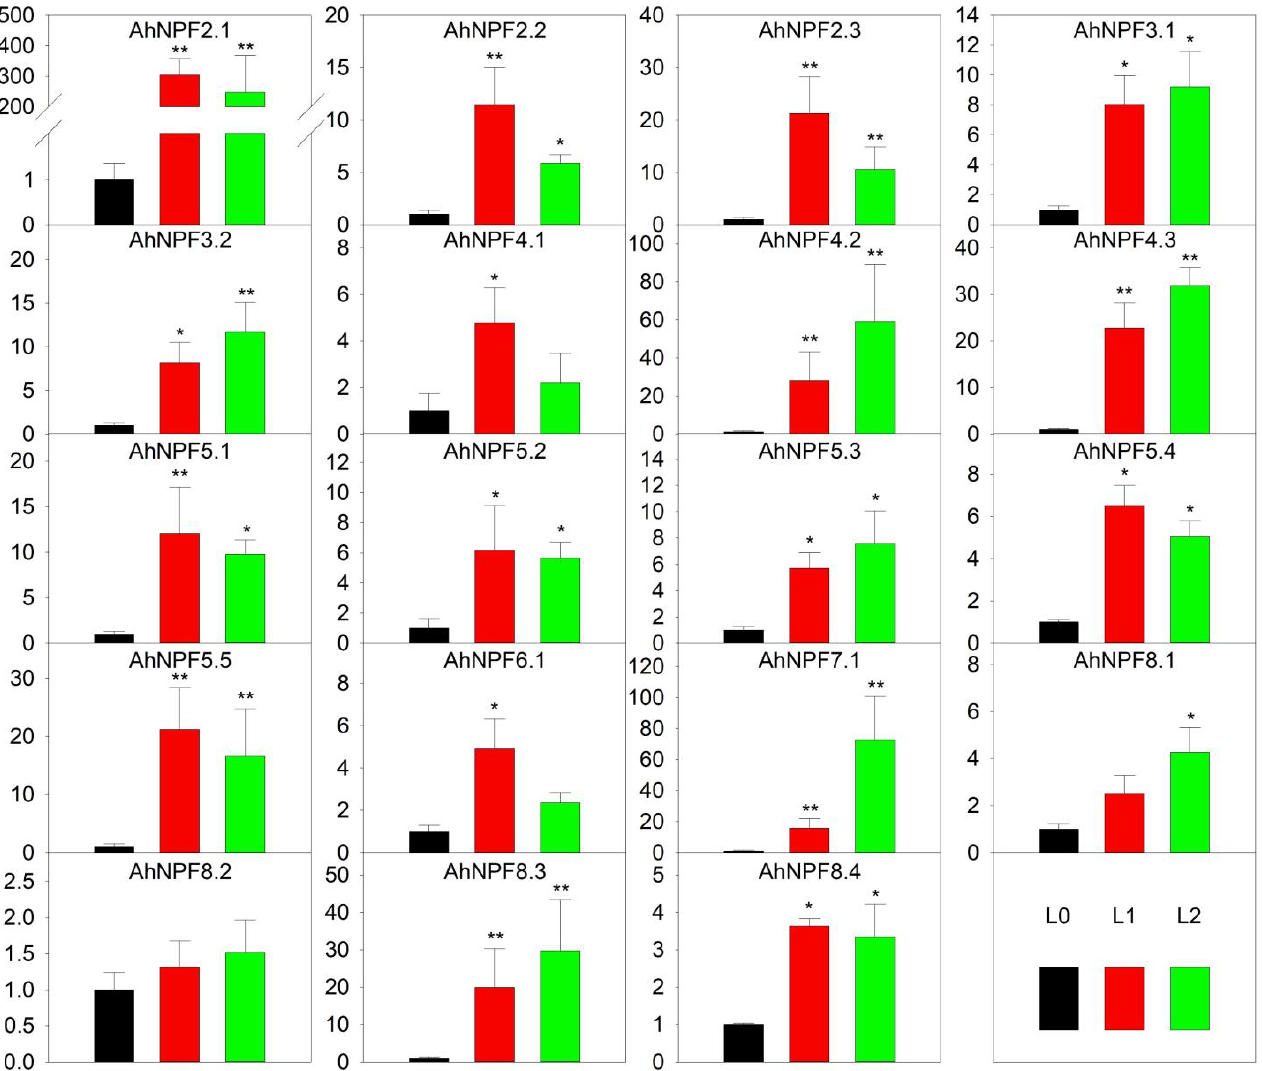
Figure 4. Expression pattern of agave NPF genes at leaf developmental stages by qRT-PCR. Y-axis represents relative expression level. L0, L1 and L2 of x-axis represent shoot, unexpanded leaf and expanded leaf, respectively. The error bar represents the standard error. * and ** represent that expression level was increased or decreased by more than 3-fold and 10-fold compared with L0, respectively. The expression values of L0 stages were normalized as 1.